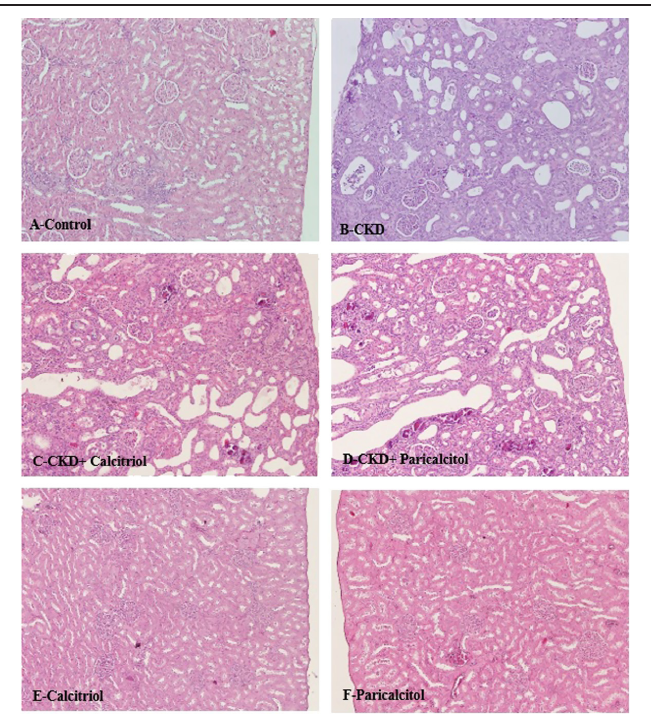
Figure 4. Histopathological evaluation of control, CKD, CKD + calcitriol, CKD + paricalcitol, calcitriol, and paricalcitol groups (hematoxylin and eosin, × 4). (A) Structures of glomerulus and tubules are normal in the control group. (B) In the CKD group, there are vacuolization, dilatation, necrosis in the tubules, and inflammatory cell infiltration in the perivascular and interstitial area. (C-D). In CKD + calcitriol and CKD + paricalcitol groups, there are vacuolization, dilatation, necrosis, inflammatory cell infiltration in the perivascular, interstitial area, and medulla papillary microcalcification in tubular structures. (E-F). Structures of glomerulus and tubules are normal in the calcitriol and paricalcitol groups. CKD, chronic kidney